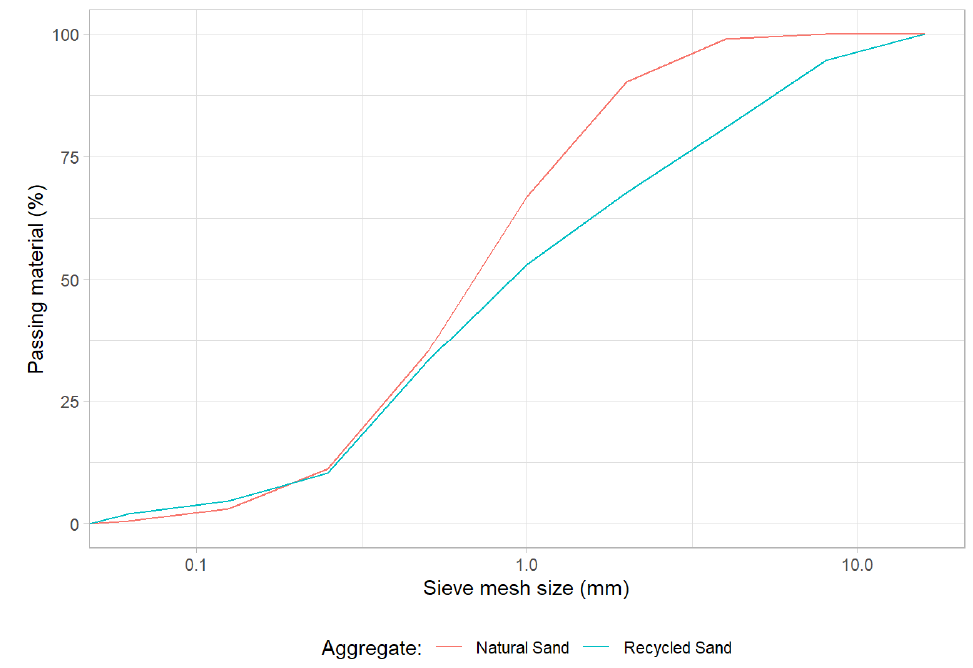
Figure 4. Grading of the natural and recycled aggregates.